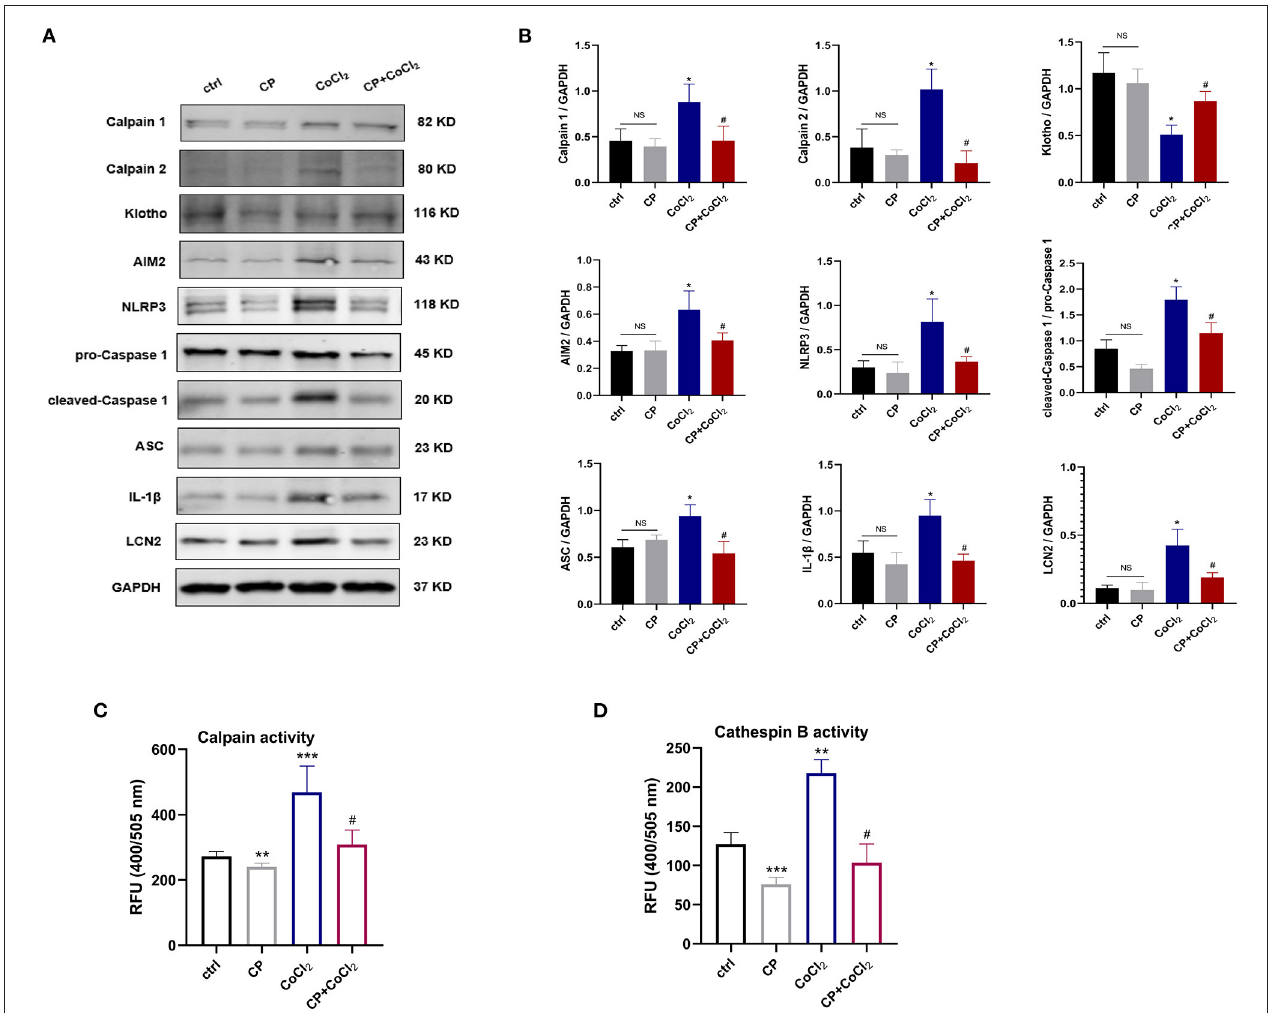
FIGURE 5 | Calpeptin suppresses AIM2 and NLRP3 inflammasome signaling pathway, and increases Klotho protein expression in CoCl 2 -induced HK-2 cells hypoxia model. (A) Western blotting of Calpain 1, Calpain 2, Klotho, AIM2, NLRP3, pro-Caspase 1, cleaved-Caspase 1, ASC, IL-1 β and LCN2 in the HK-2 cells. (B) Quantitative determination of Calpain 1, Calpain 2, Klotho, AIM2, NLRP3, cleaved-Caspase 1, IL-1 β and LCN2. (C) The calpain activity of HK-2 cells was assessed by the relative fluorescence units (400/505nm). (D) The cathepsin B activity of HK-2 cells was analyzed by the relative fluorescence units (400/505nm). All data were presented as mean ± SEM ( n = 3). NS, no significance; * p < 0.05 vs. control group; ** p < 0.01 vs. control group; *** p < 0.001 vs. control group; # p < 0.05 vs.